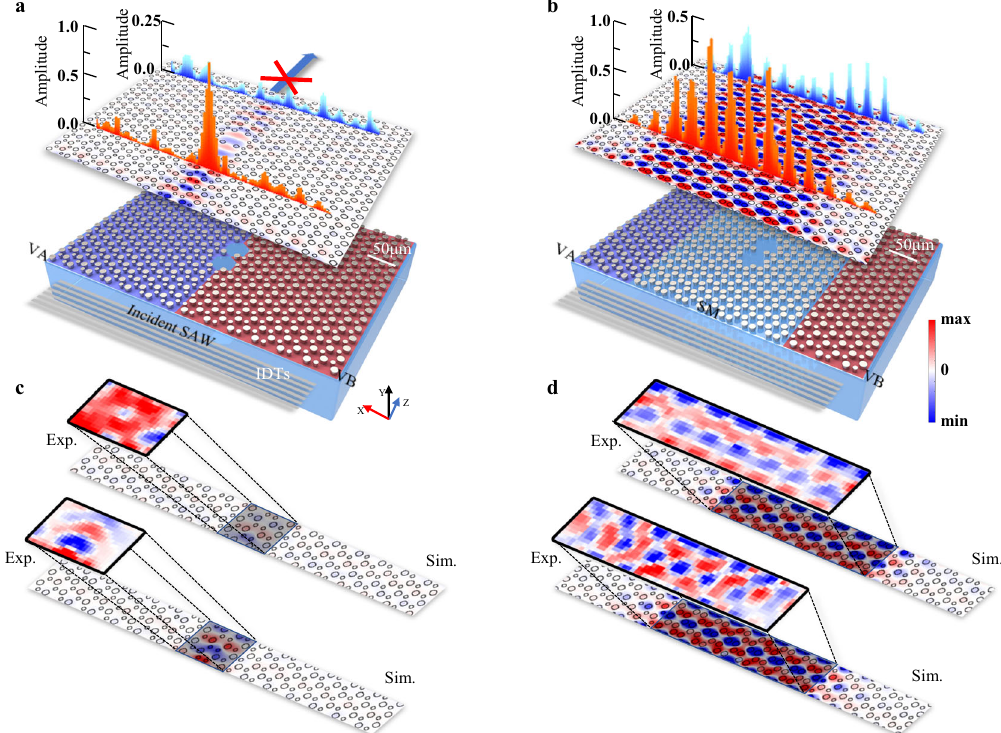
Fig. 4 Comparison of wavelength-scale defect robustness between the TVS and ETVS for SAWs. (Left panels) the TVS case; (right panels) the ETVS case. a , b (bottom) Schematics of a TVS waveguide and an ETVS waveguide have two uniform wavelength-scale vacuum defects embedded. Blue, red, light blue shaded areas are the VA, VB, and the defects; the SM remains unshaded. In the experiment, the same planar SAWs are injected into these two samples. (upper) Calculated SAW out-of-plane distributions on the surface of the two samples. 1D red and blue bars are experimental measured SAW out-of-plane amplitude before and behind the defects. c , d Calculated and experimental imaged SAW out-of-plane displacement distributions before and behind the defects in both the